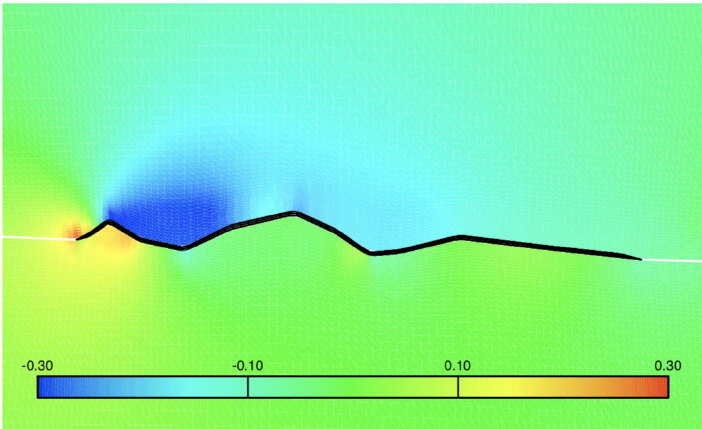
Figure 10. Mean pressure distribution of a corrugated airfoil at angle of attack of 2 ◦ and Re =